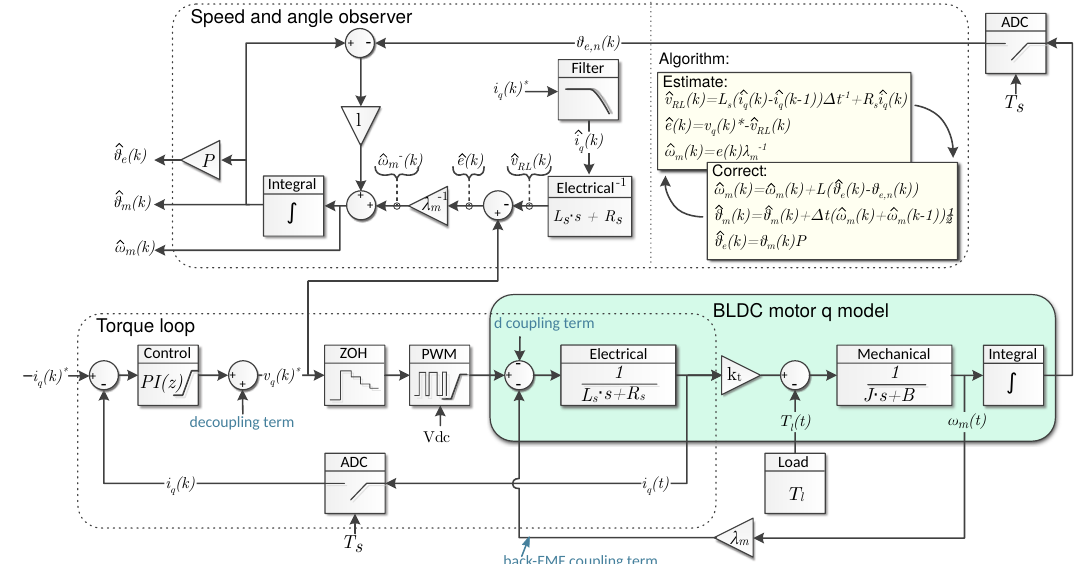
Figure 5. Illustration of the torque loop and speed and angle observer proposed in this section. The light-yellow boxes outline the algorithms used for the observer. The decoupling term is proposed to be 0V but can be included if needed.